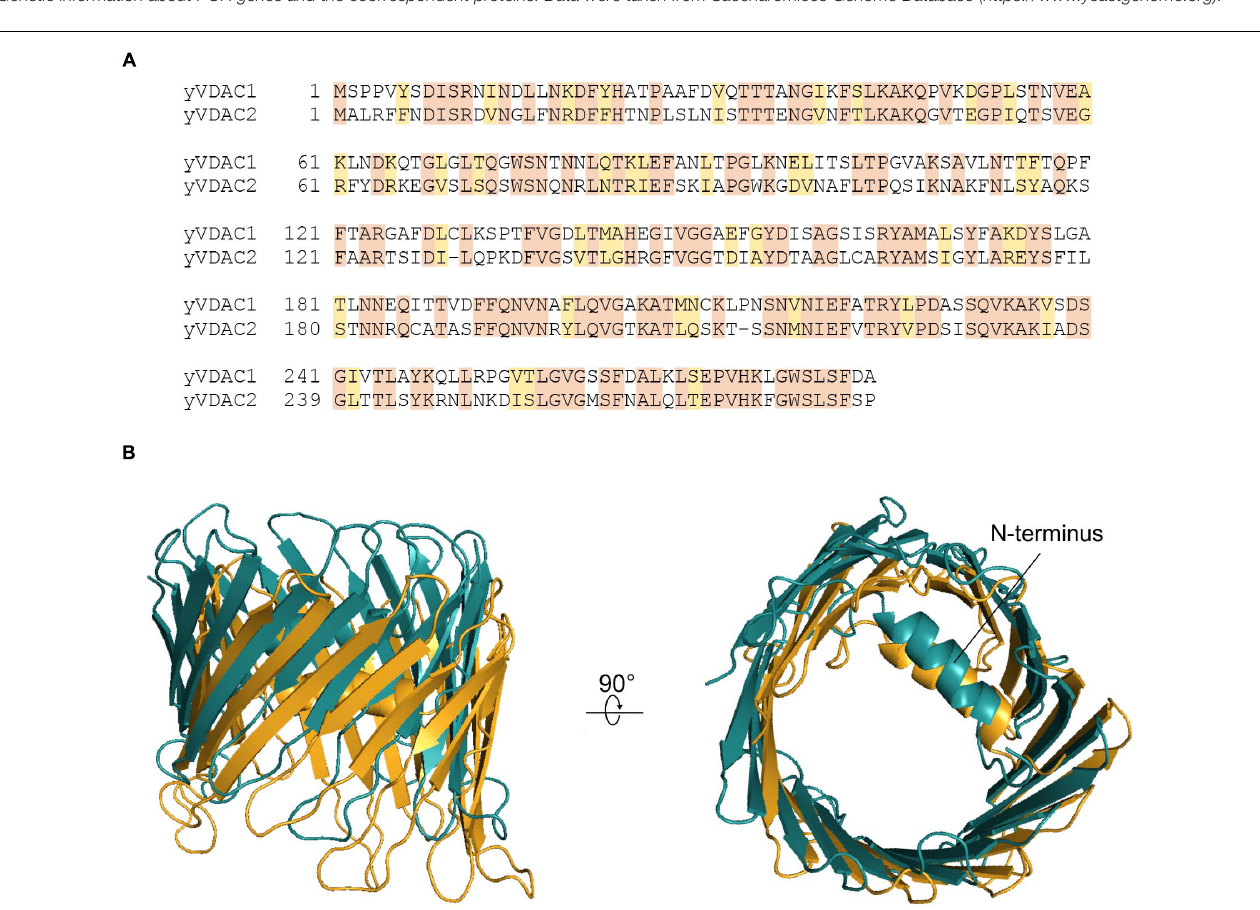
TABLE 1 | Main features of POR genes and proteins. Gene ORF Location Position Size (bp) Protein length (aa) POR1